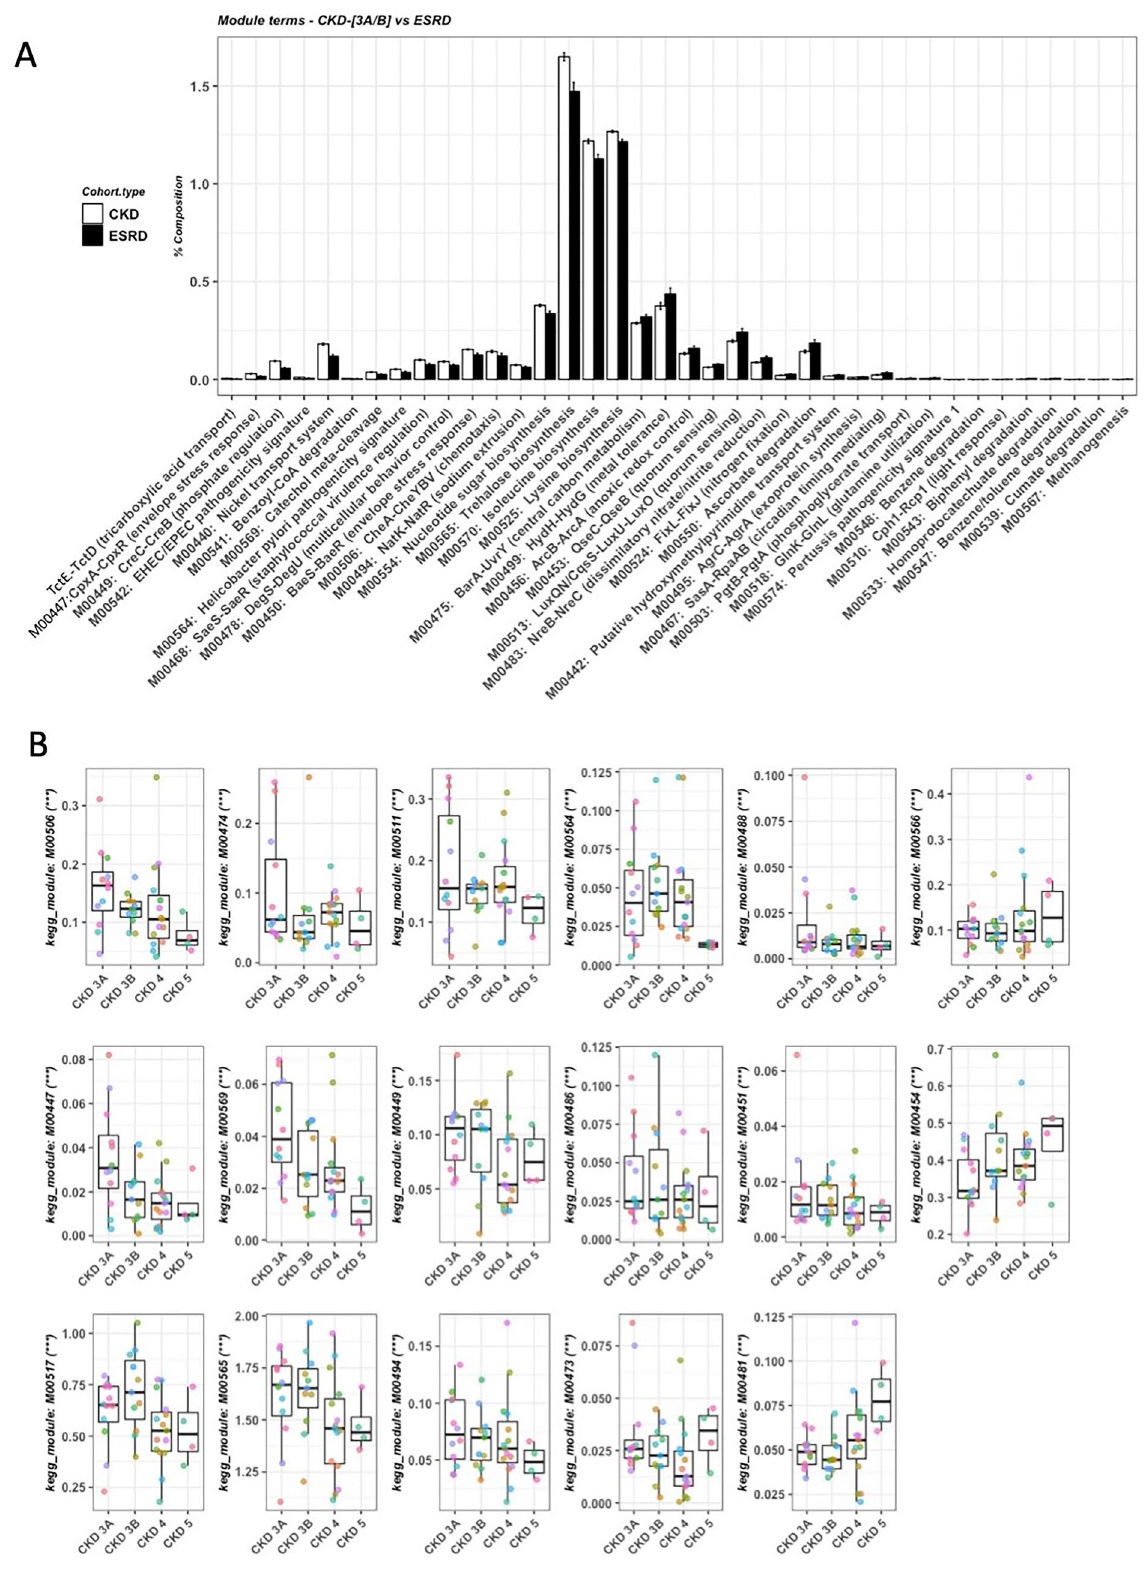
Figure 5. KEGG modules. ( A ) Significant KEGG modules between early stage CKD (n = 23) and ESRD patients (n = 10). Wilcox-rank sum test was used to calculate p-values of top 100 modules and multiple testing was corrected using FDR (FDR < 0.05 were shown). ( B ) KEGG modules significantly associated with the severity of CKD (FDR < 0.05). Association was calculated by Maaslin2. KEGG definitions: Supplementary Table S4. ***FDR < 0.0005; **FDR < 0.005; *FDR <